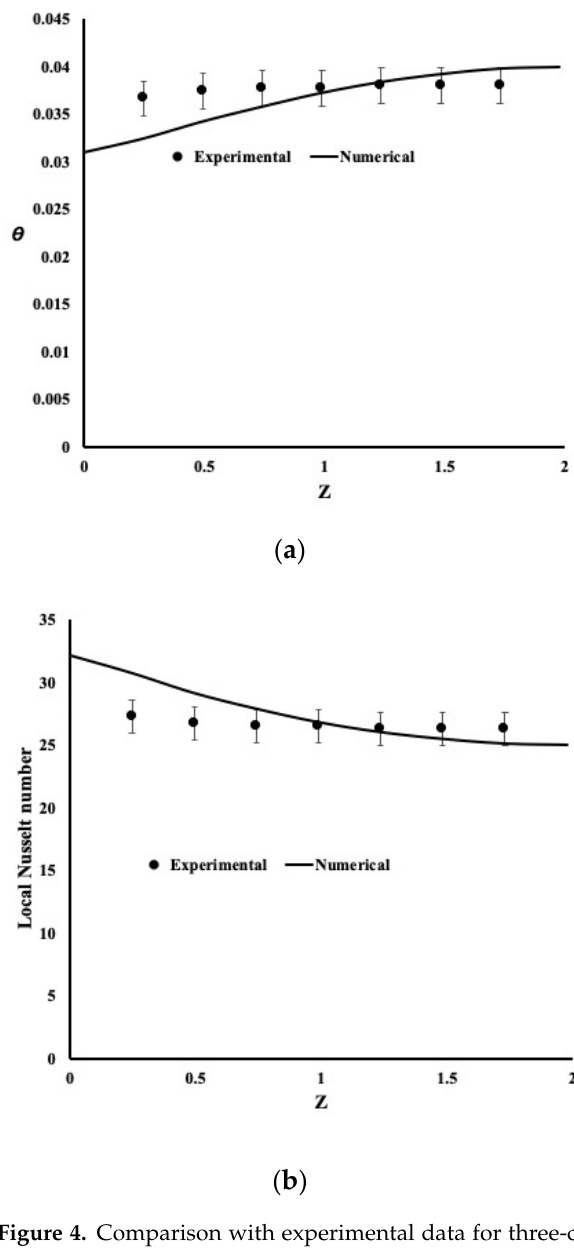
Figure 4. Comparison with experimental data for three-channel configurations. ( a ) Temperature variation along with the flow; ( b ) Local Nusselt number along with the flow. With a mesh sensitivity showing a good number of elements is used in our model and with a good agreement between the experimental and numerical results, the proposed finite element model is accurate and is adopted in our